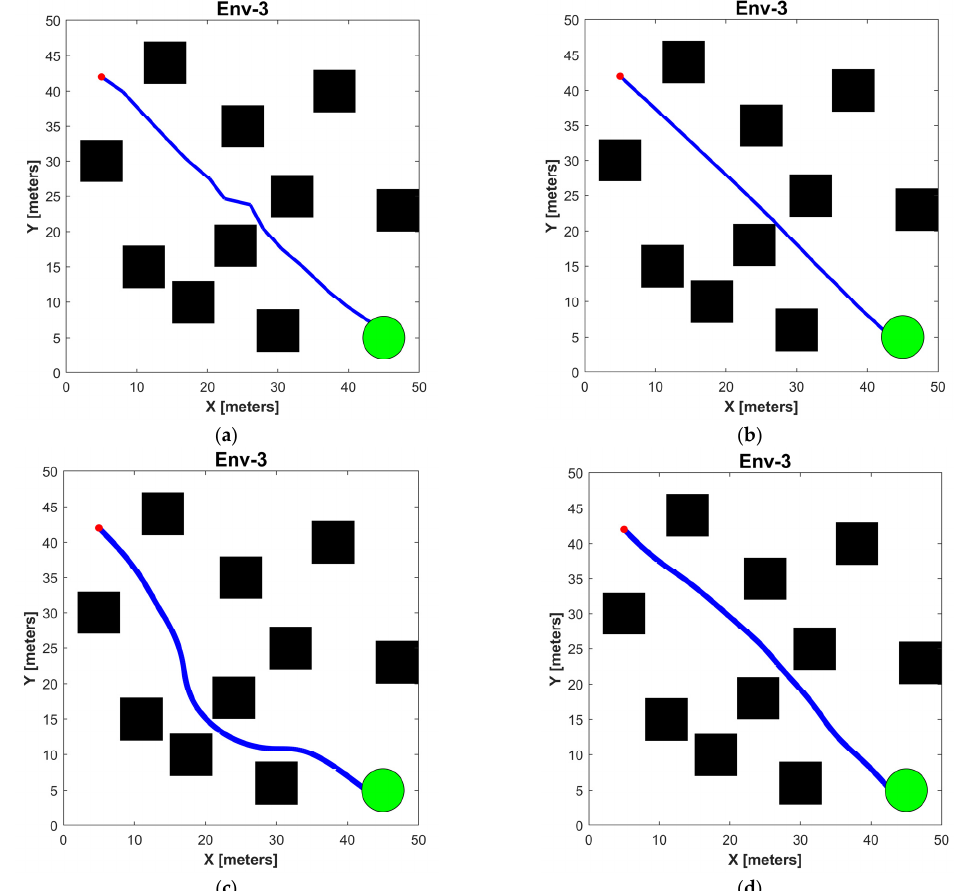
Figure 11. Results of path under scenario 3: ( a ) RRT*; ( b ) Informed ‐ RRT*; ( c ) spRRT; ( d ) spRRT ‐ Informed.